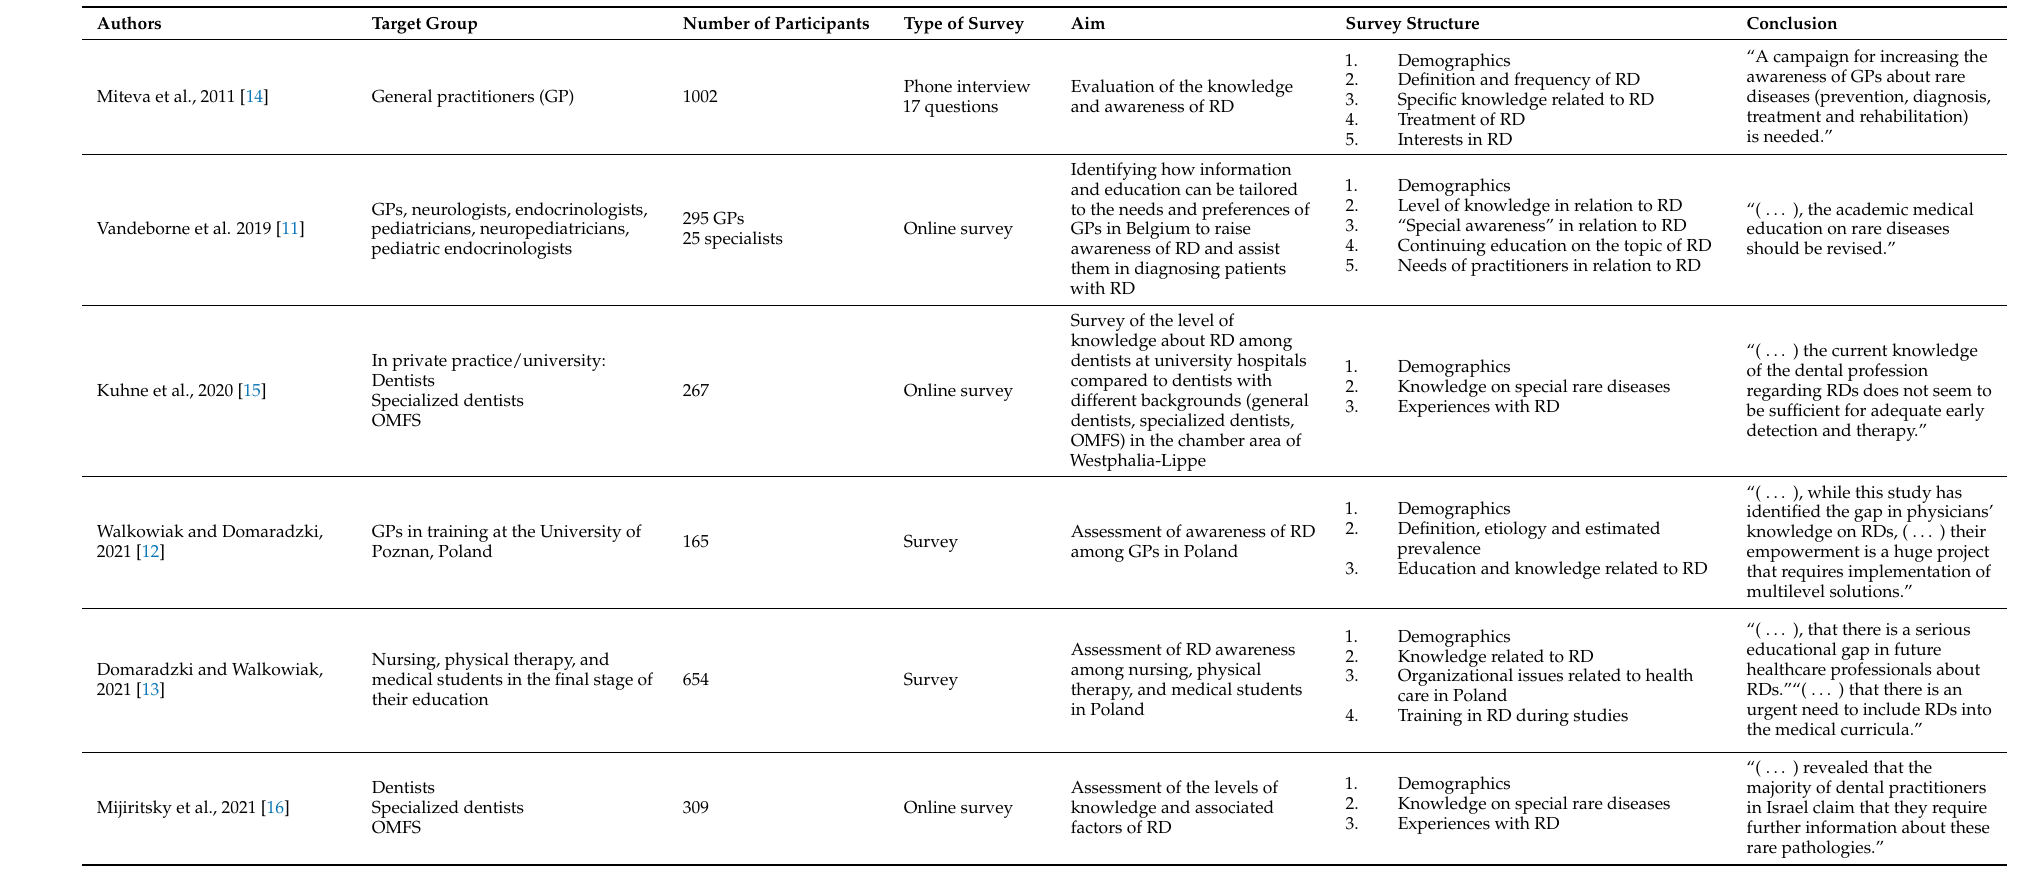
Table 10. Overview of published studies on awareness and knowledge of